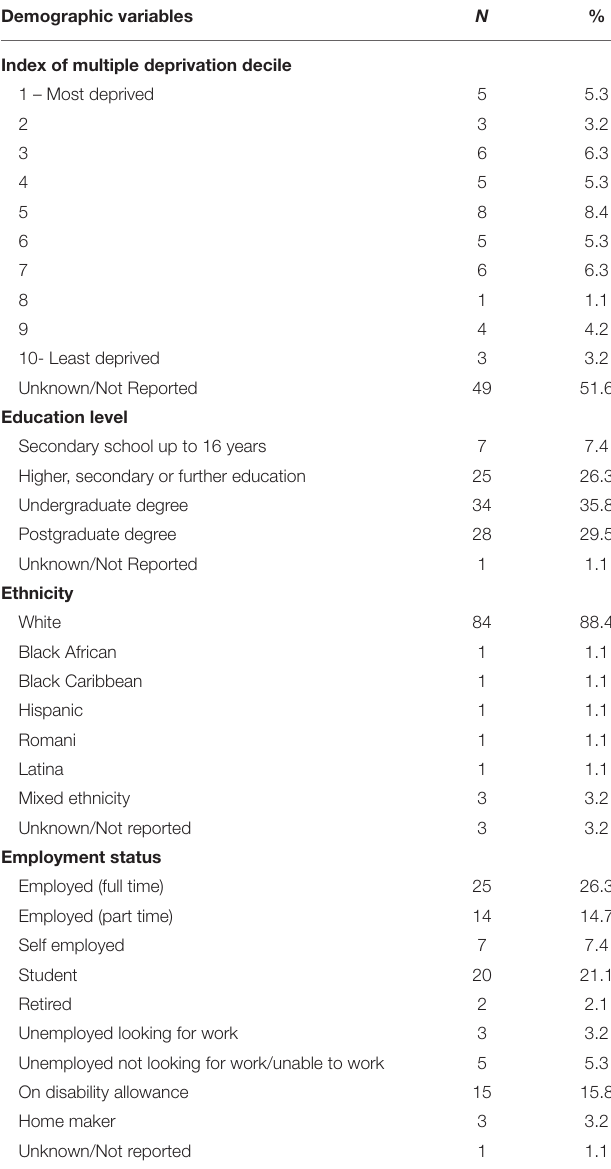
TABLE 1 | Summary of autistic adults’ demographic information collected at Time